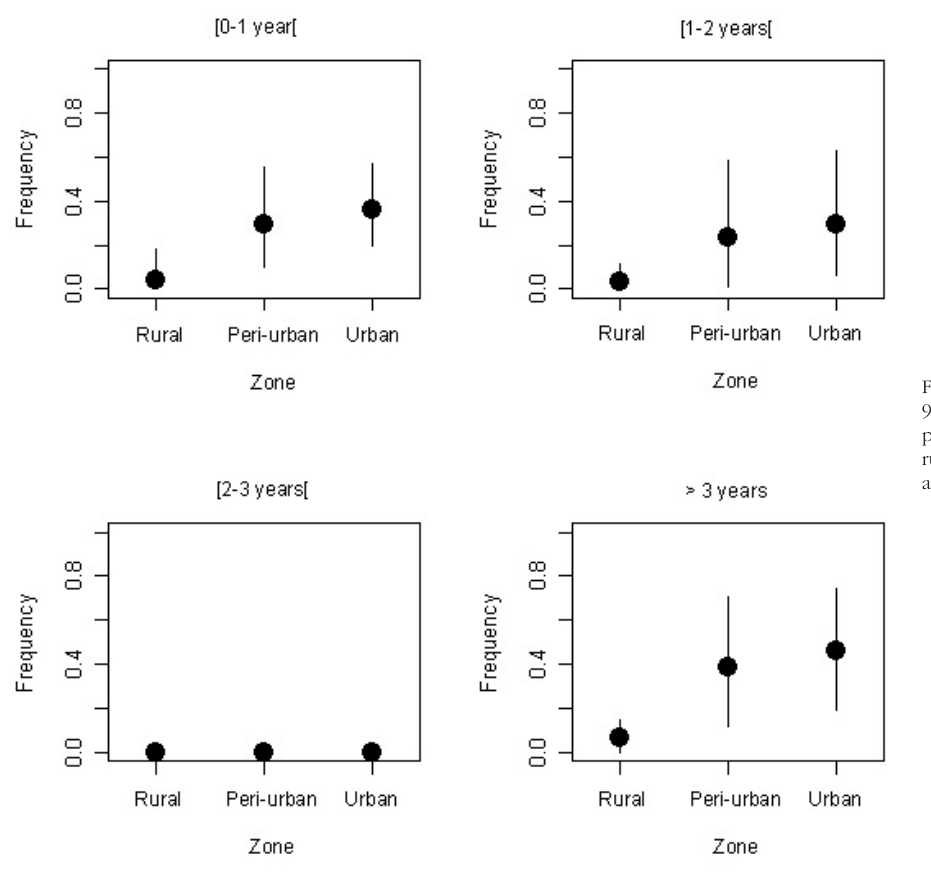
“zone + anthro” and “zone” and “zone + anthro + mat” (Table IV). Retaining the most parsimonious model, prevalence was mainly explained by the zone (Pearson goodness-of-fit test: p = 0.41, AUC = 0.78). Foxes from the urban area had the lowest prevalence (OR = 0.04, CI = 0.007-0.17) with a likely decrease of infection pre- valence of foxes with anthropogenic food consump- tion (OR = 0.17, CI = 0.009-1) independent of urba- nisation. Among infected foxes, a difference in worm burden was detected between those animals having eaten A. terrestris and/or Microtus sp. and those that did not; Kruskal-Wallis test (p =